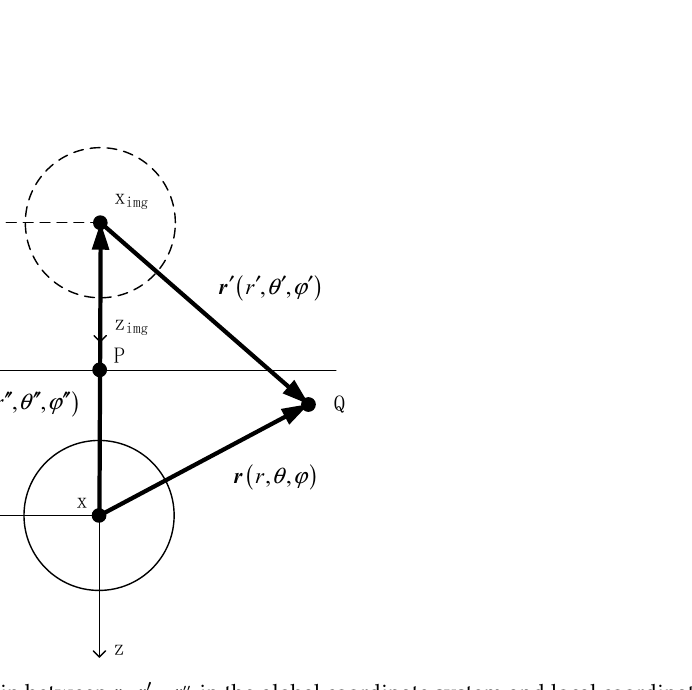
′ ′′ r,r ,r in the global coordinate system and local coordinate sys- sr B A sr nm nm